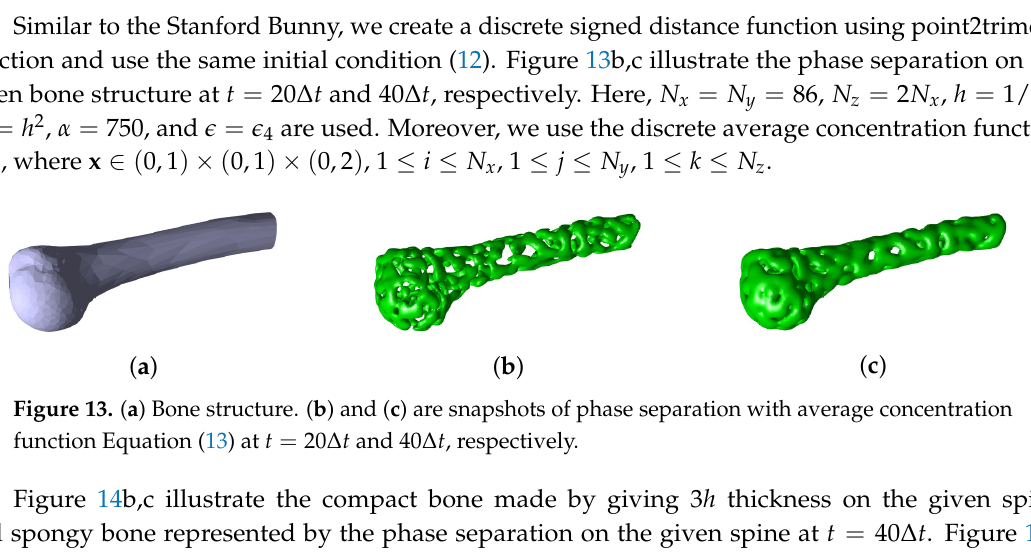
Figure 12. Porous structure inside the bone. Reprinted with permission from Gong et al. [30]. Copyright 2015, Springer Nature.